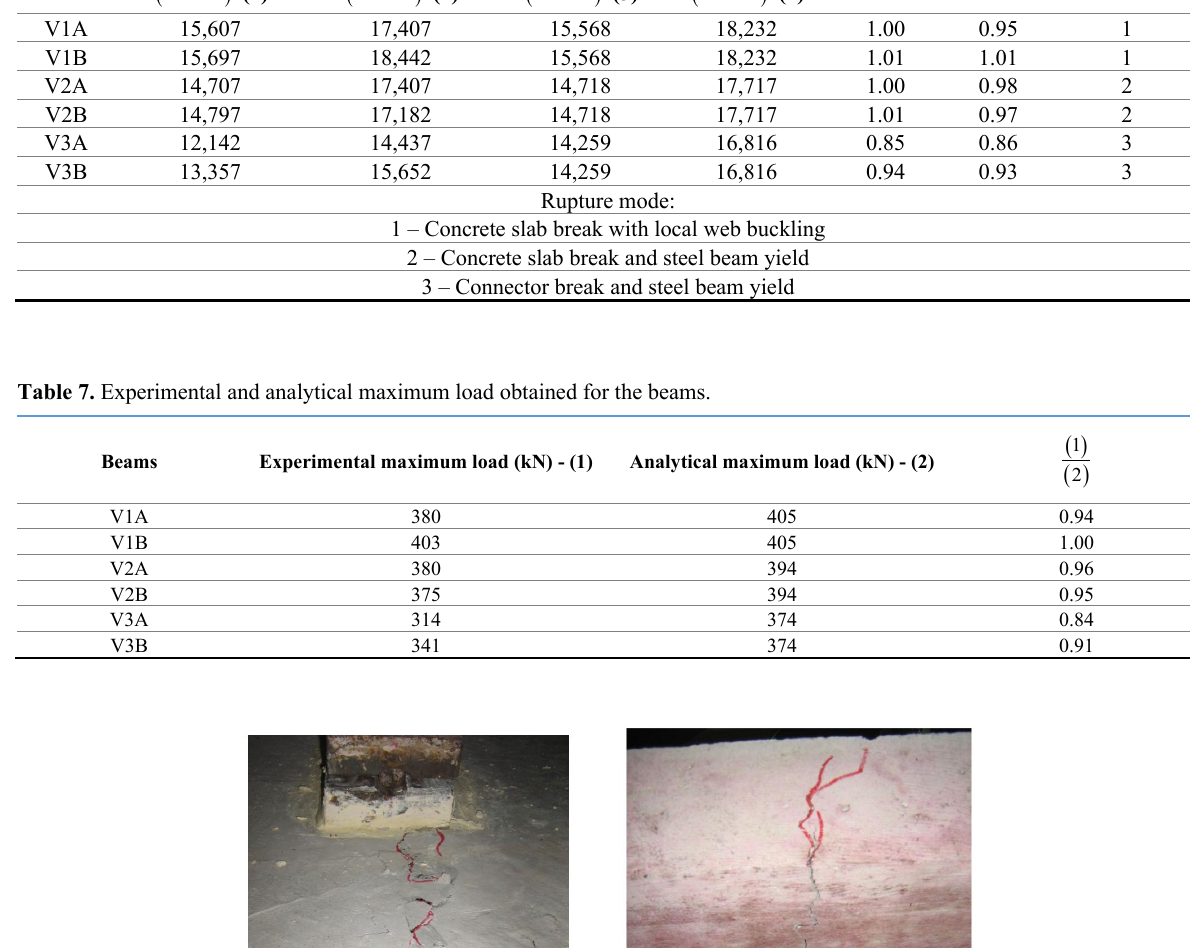
Table 6. Resistant moments Experimental and analytical. Experimental Beam